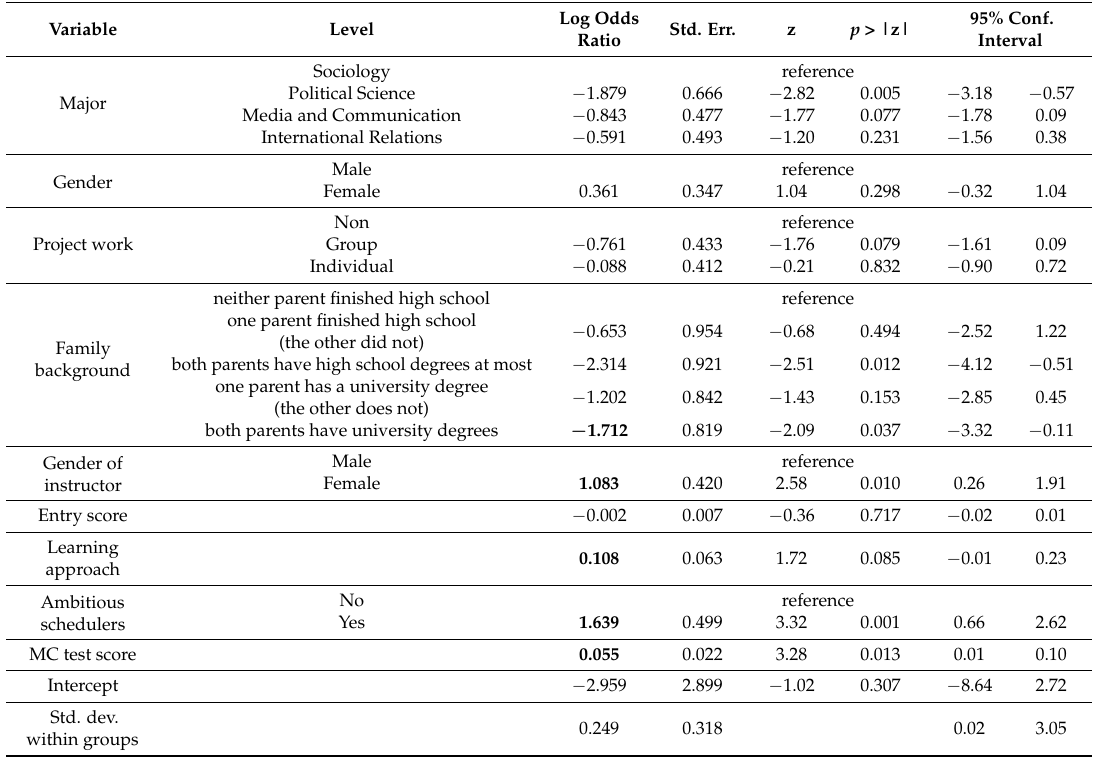
Table 3. Results for the random effects logistic regression model. Log Odds Ratios significant on a level of p < 0.1 are shown in